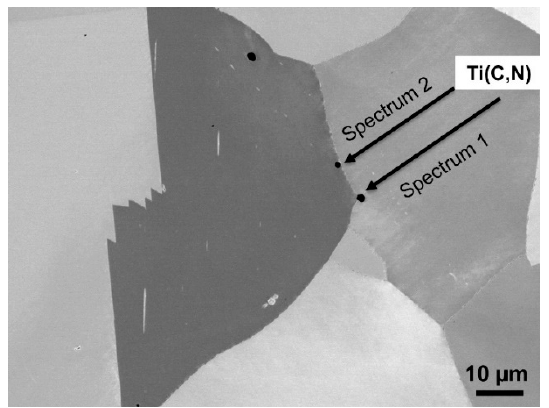
Figure 3. Scanning electron micrograph of the morphology of a titanium carbonitride precipitate in the grain boundary and interior. Table 3. Chemical compositions, in wt. %, of the precipitates depicted in Figure 3, measured using energy dispersive X-ray